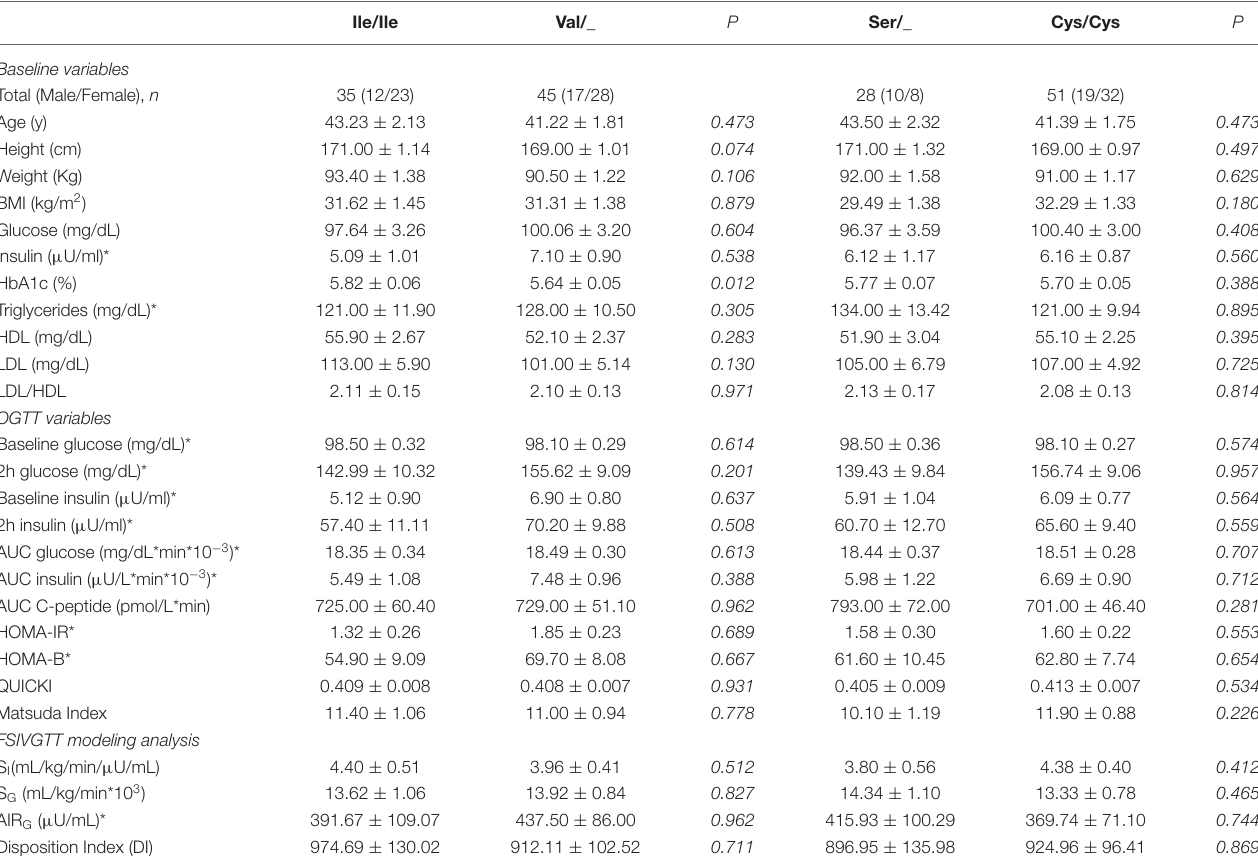
TABLE 2 | Baseline and metabolic responses to an OGTT and FSIVGTT in adults with various levels of BMI and glucose control grouped by two common TAS1R2 polymorphisms. Ile/Ile Val/_ P Ser/_ Cys/Cys P